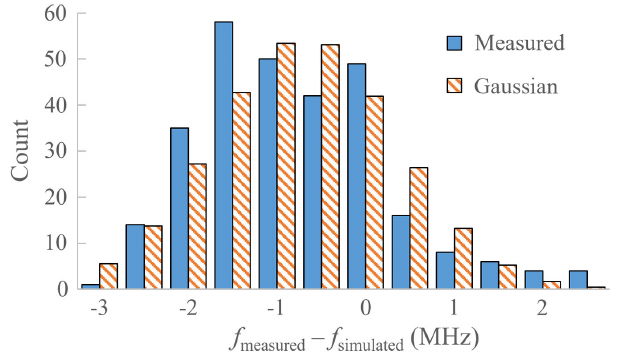
FIG. 5. Measured mode detuning distribution for the lowest two dipole passbands in MESA cavity compared to Gaussian